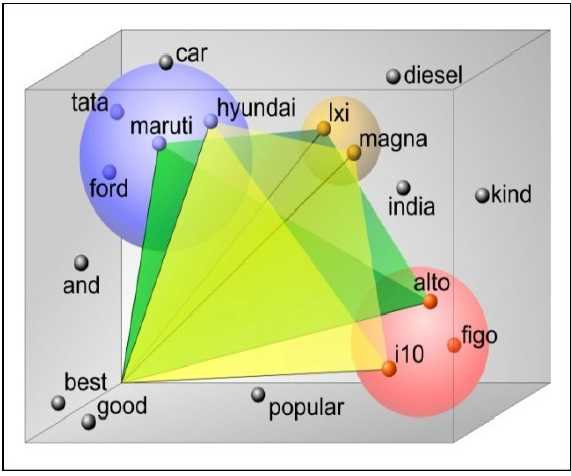
Figure 1. Example of word